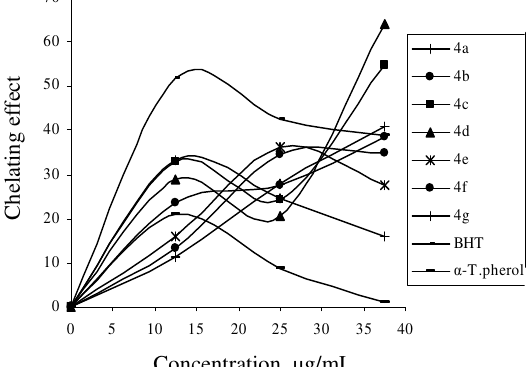
Figure 3. Metal chelating effect of different amount of the compounds 4a-g , BHT and α - tocopherol on ferrous ions.